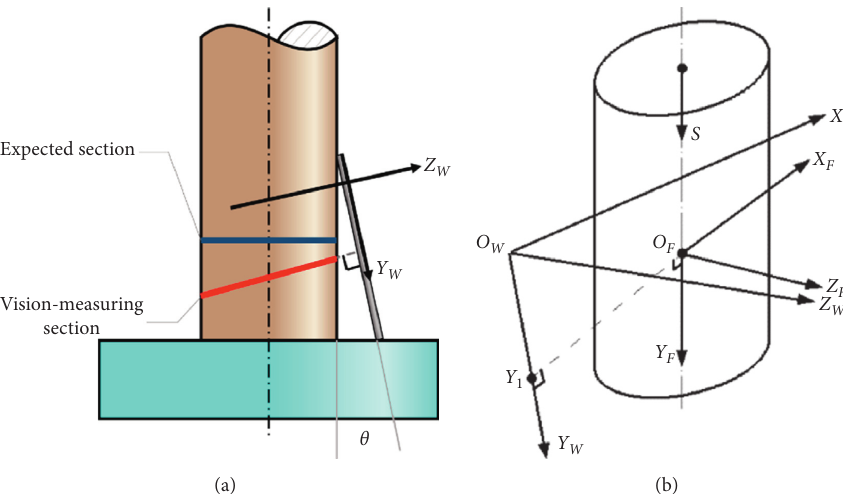
Figure 15: Coordinate systems involved in measurement: (a) positional relationship between world coordinate system and specimen; (b) schematics of specimen coordinate system as